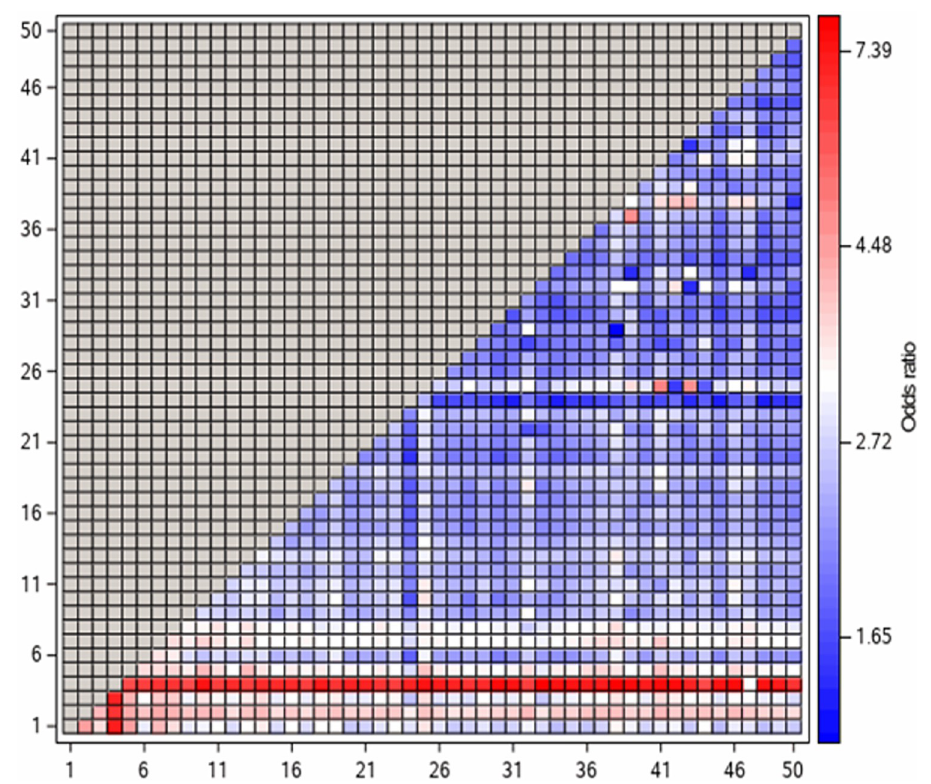
Fig 1. Heatmap of ORs of ADR-related hospital admission in patients using combinations of least two medicine classes, i.e., mean predicted probability of being a case with each combination compared to the 5 th percentile of predicted probability. Decodes for the number of each medicine class are provided in Table